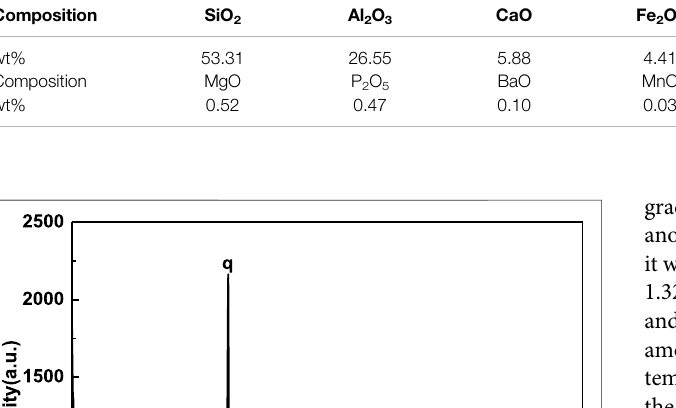
TABLE 1 | Chemical compositions of coal fl y ash powder. Composition